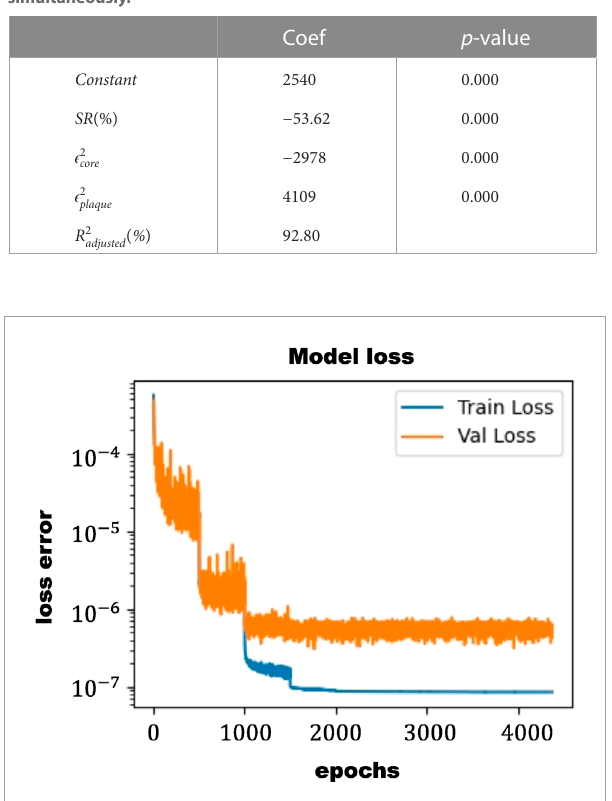
FIGURE 5 Loss function for training and validation step evaluated with the MSE.